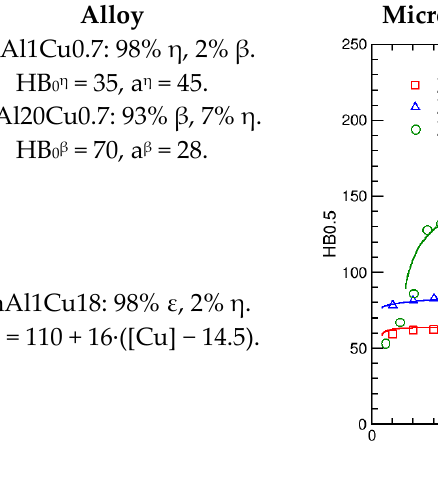
Figure 8. Measured and simulated microhardness for as-cast samples. In the left column, the phase fractions after solidification as derived from the simulations and the parameters for the hardness model are shown.